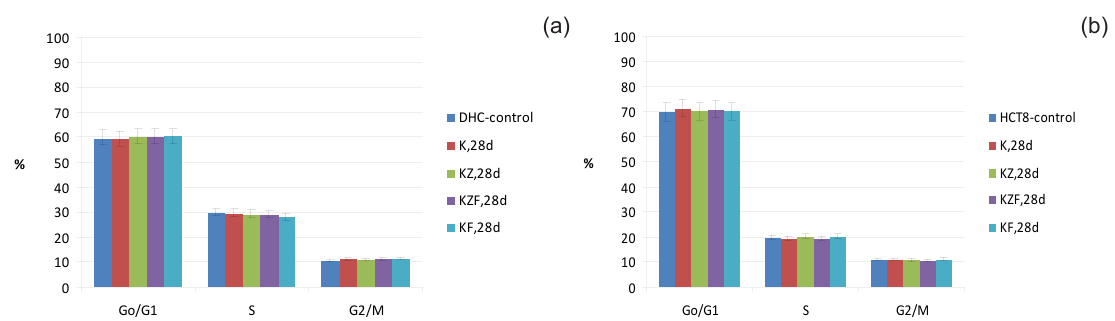
* calculated based on the weight loss recorded between 400-575°C; ** calculated considering also Ca(OH) between 575-1000°C)